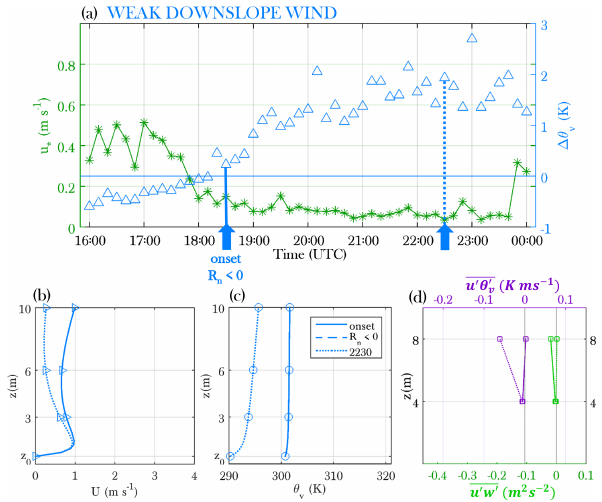
Figure 8. (a) Time evolution of the friction velocity ( u ∗ ) and ther- mal stratification ( (cid:49)θ v = θ v ( 10m ) − θ v ( 3m ) ) for the weak downs- lope event (13 August 2017). The horizontal line represents (cid:49)θ v = 0. The solid arrow with the tied vertical lines points to three times of interest: the solid line indicates the onset time, the dashed line the time at which R n turns negative, and the dotted line is depicted at 22:30UTC when the SBL is already well developed. Vertical pro- files of (b) the wind speed ( U ), (c) virtual potential temperature ( θ v ) and (d) u (cid:48) w (cid:48) and u (cid:48) θ (cid:48) v turbulent fluxes at the three times of interest are shown below.